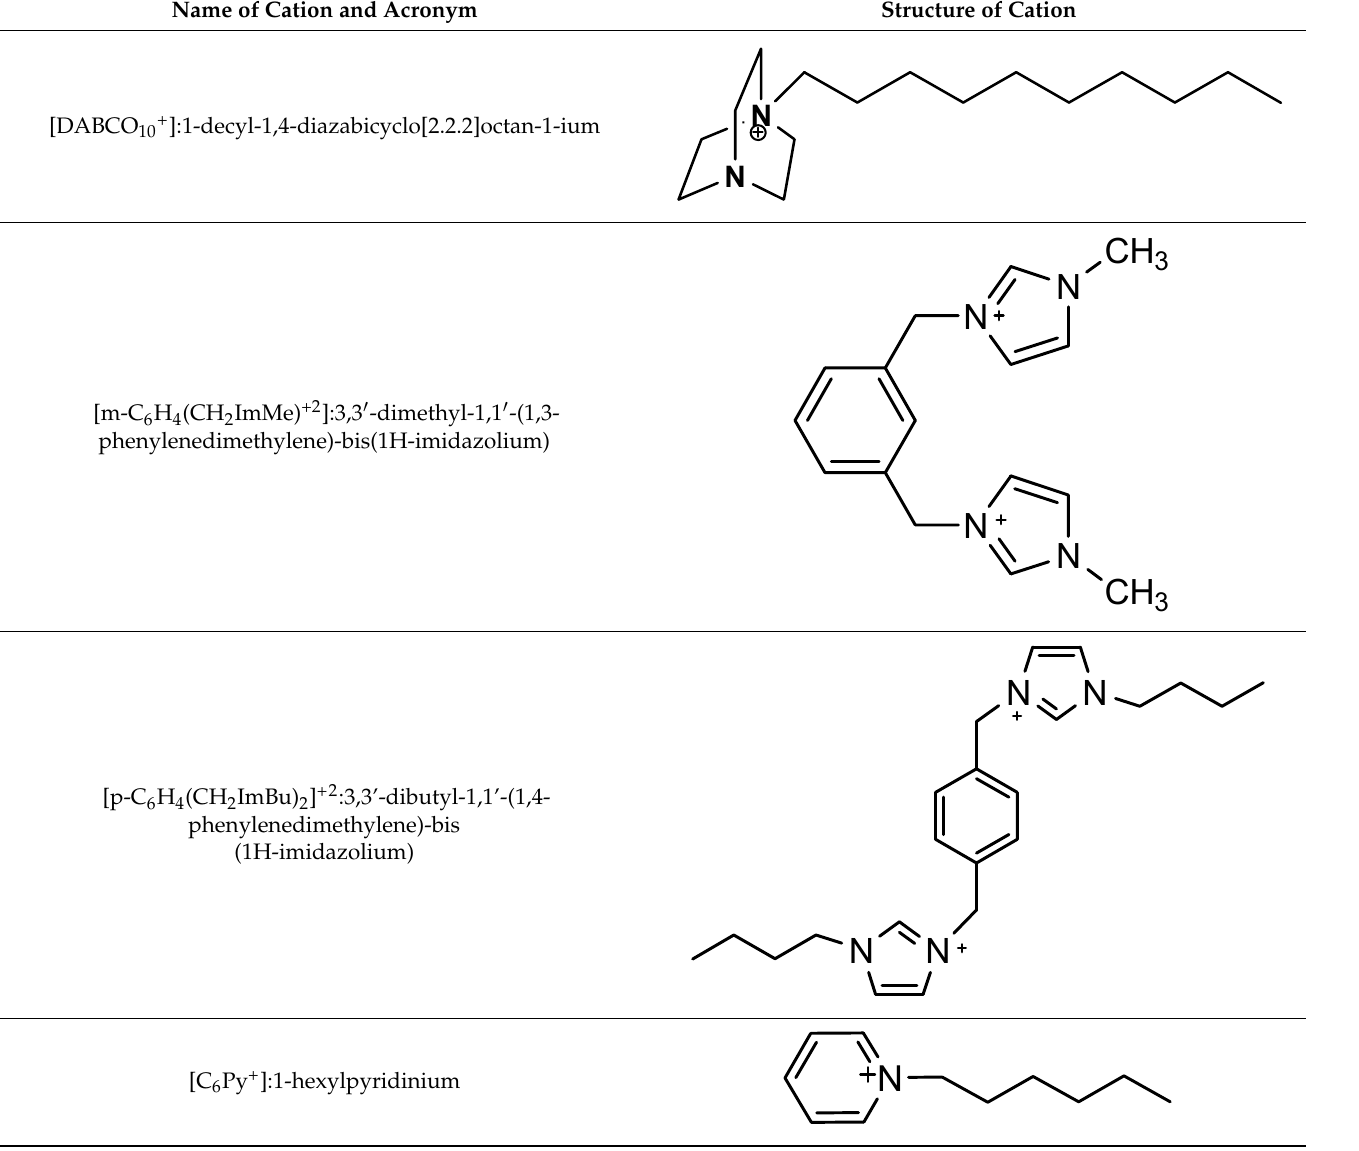
Table 1. Name, acronym and structure of the different cations of the four ionic liquids. Name of Cation and Acronym